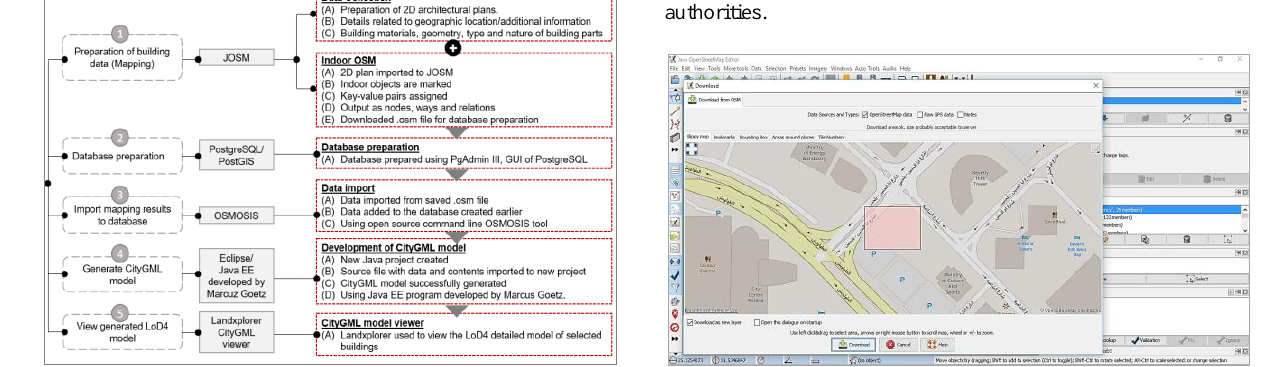
Figure 4. Methodology of research Figure 5. Footprint downloaded from OSM server for mapping Specific information, dimensions and interior structures of the tower were added to the data obtained from architectural floor plans. Initially, an OSM account was created to download